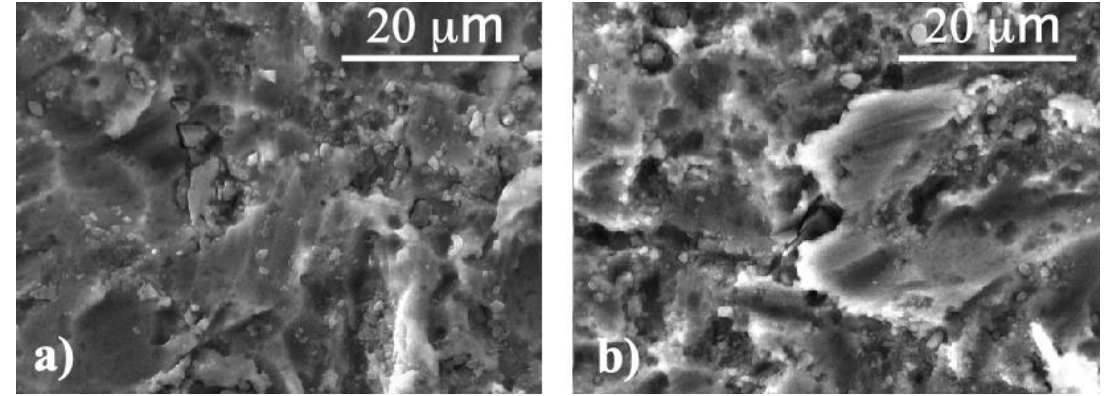
Figure 3. SEM micrographs of ( a ) sample N5 and ( b ) sample